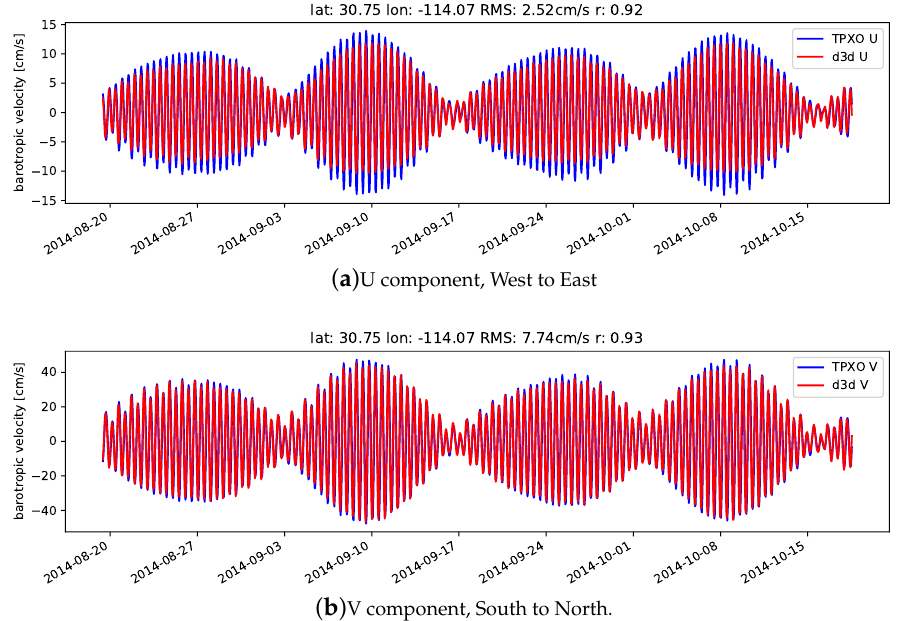
Figure 6. Time-series of components of the barotropic current at latitude 30.75 N, longitude—114.07 E. The delf3D (d3d) components have been depth averaged for comparison. All dates in UTC.